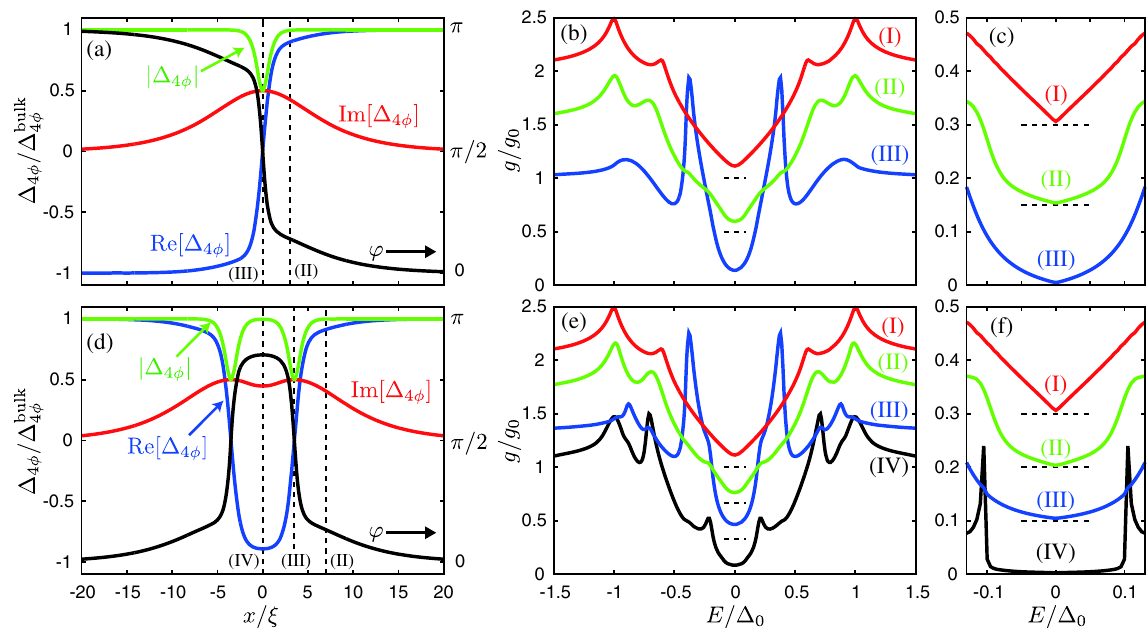
FIG. 5. (a) A model order parameter Δ 4 ϕ ð x Þ with a TB located at x ¼ 0 . LDOS in the bulk (I), at x ¼ 3 ξ (II), and on a TB (III), which are calculated with an energy smearing of η ¼ 0 . 03 Δ 0 (b) and η ¼ 0 . 001 Δ 0 (c). The lines (I) and (II) have offsets g 0 and 0 . 5 g 0 in (b) and 0 . 3 g 0 . 15 g 0 and 0 in (c), respectively, where g 0 is the density of states in the normal state at the Fermi energy. (d) A model order parameter Δ 3 . 5 ξ . The LDOS in the bulk (I), at x ¼ 7 ξ (II), on a TB (III), and at the middle point between 4 ϕ ð x Þ with double TBs located at x ¼ (cid:1) double TBs (IV), which are calculated with η ¼ 0 . 03 Δ 0 (e) and η ¼ 0 . 001 Δ 0 (f). The lines (I), (II), and (III) have offsets g 0 , ð 2 = 3 Þ g 0 , and ð 1 = 3 Þ g 0 in (e) and 0 . 3 g 0 , 0 . 2 g 0 , and 0 . 1 g 0 , in